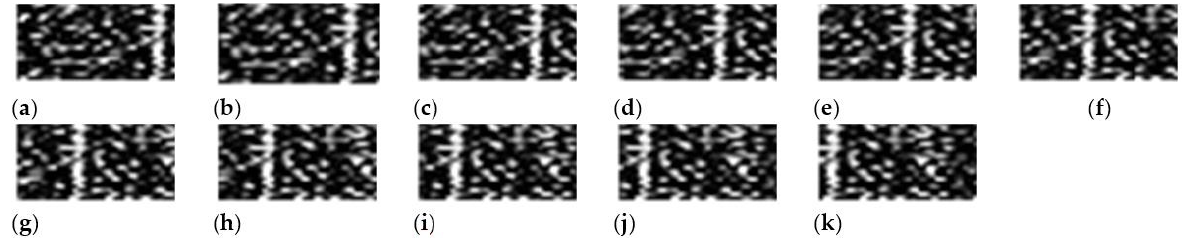
Figure 15. Partial 40 × 20 sample graph with target under the condition of 0 dB SNR, and the target in unit positions are ( a ) 0.9, ( b ) 0.825, ( c ) 0.75, ( d ) 0.65, ( e ) 0.575, ( f ) 0.45, ( g ) 0.4, ( h ) 0.325, ( i ) 0.25, ( j ) 0.175, and ( k ) 0.1.